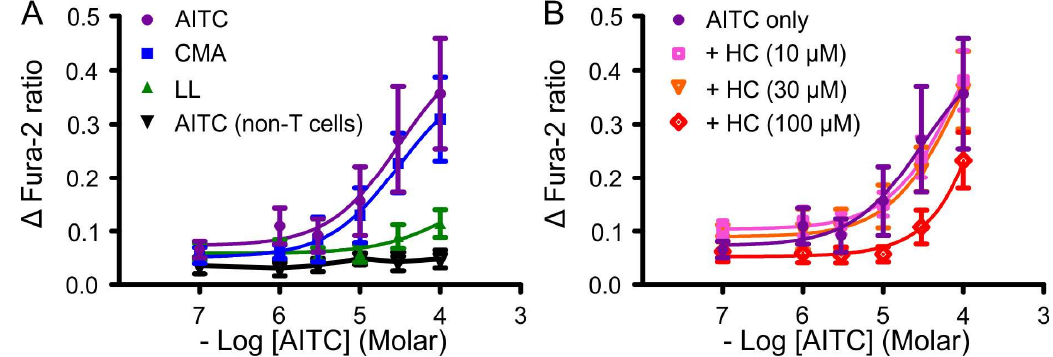
Figure 1. Concentration ‐ response relationships for TRPA1 agonists and the effect of a TRPA1 receptor antagonist on HEK393 cells transfected with the Trpa1 gene. ( A ) Calcium mobilisation (expressed as ∆ Fura-2 ratio) in response to allyl isothiocyanate (AITC), cinnamaldehyde (CMA) and linalool (LL); ( B ) The inhibitory effect of graded concentrations of HC ‐ 030031 (HC) on the response to AITC in the transfected cells. Neither the agonists nor the antagonist had any effect in the HEK293 cells that were not transfected with Trpa1 , indicated by AITC (non ‐ T cells) in ( A ). The weak effect of linalool is reflected in the studies of mucosal function.